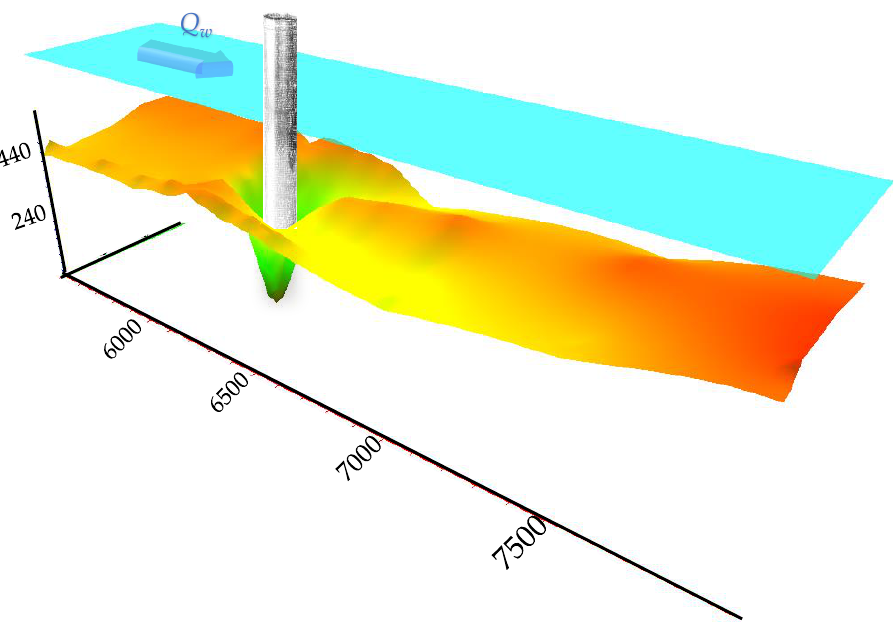
Figure 5. Measuring grid and 2D contour plan of scour for laboratory data for Q w = 0.036 m 3 s −1 , h 0 = 0.10 m (basing on own laboratory data).